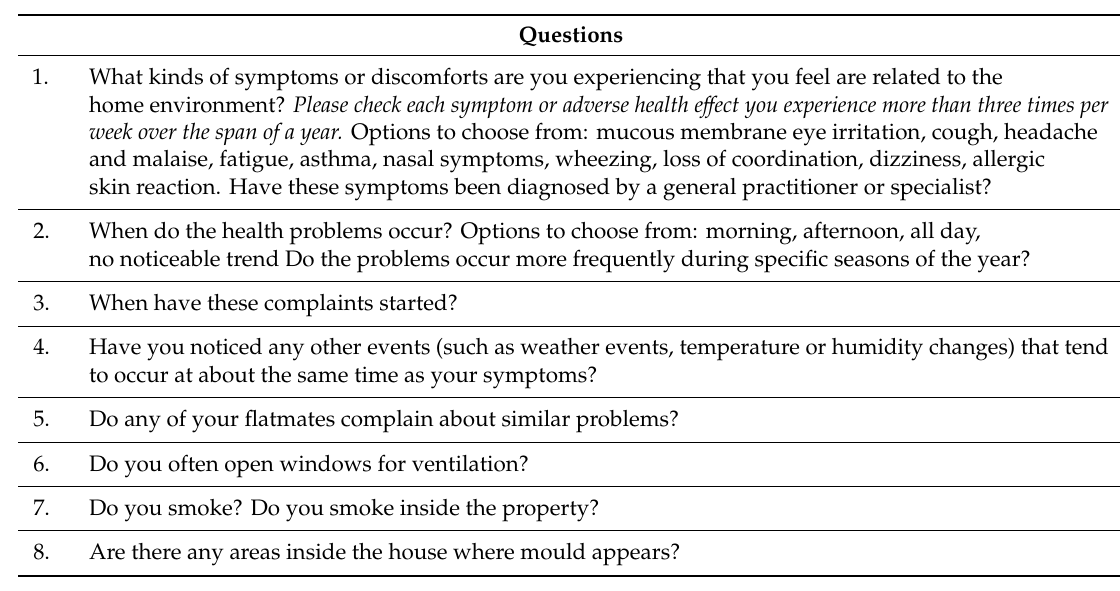
Table 1. Questions presented to people permanently residing in apartments, where there was a problem with